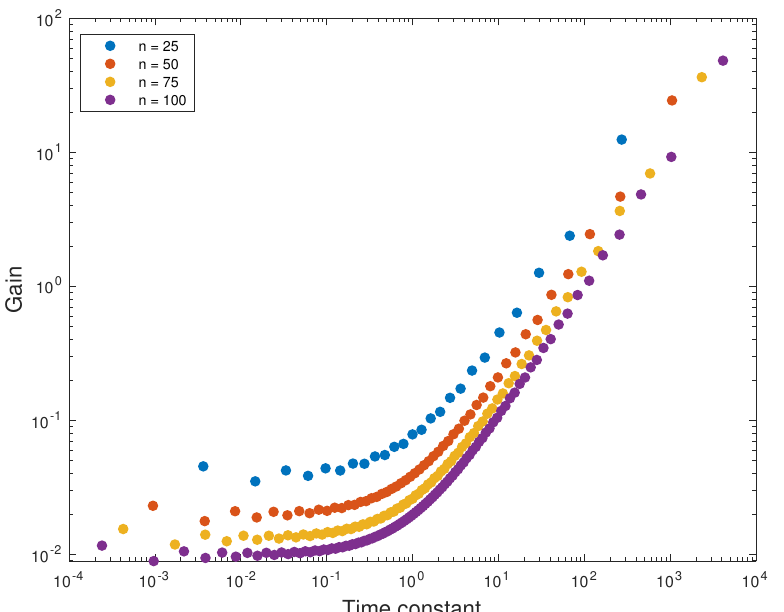
Figure 6. Comparison of time constants and gains of elements of approximating sum for Fourier– Chebyshev approximation.